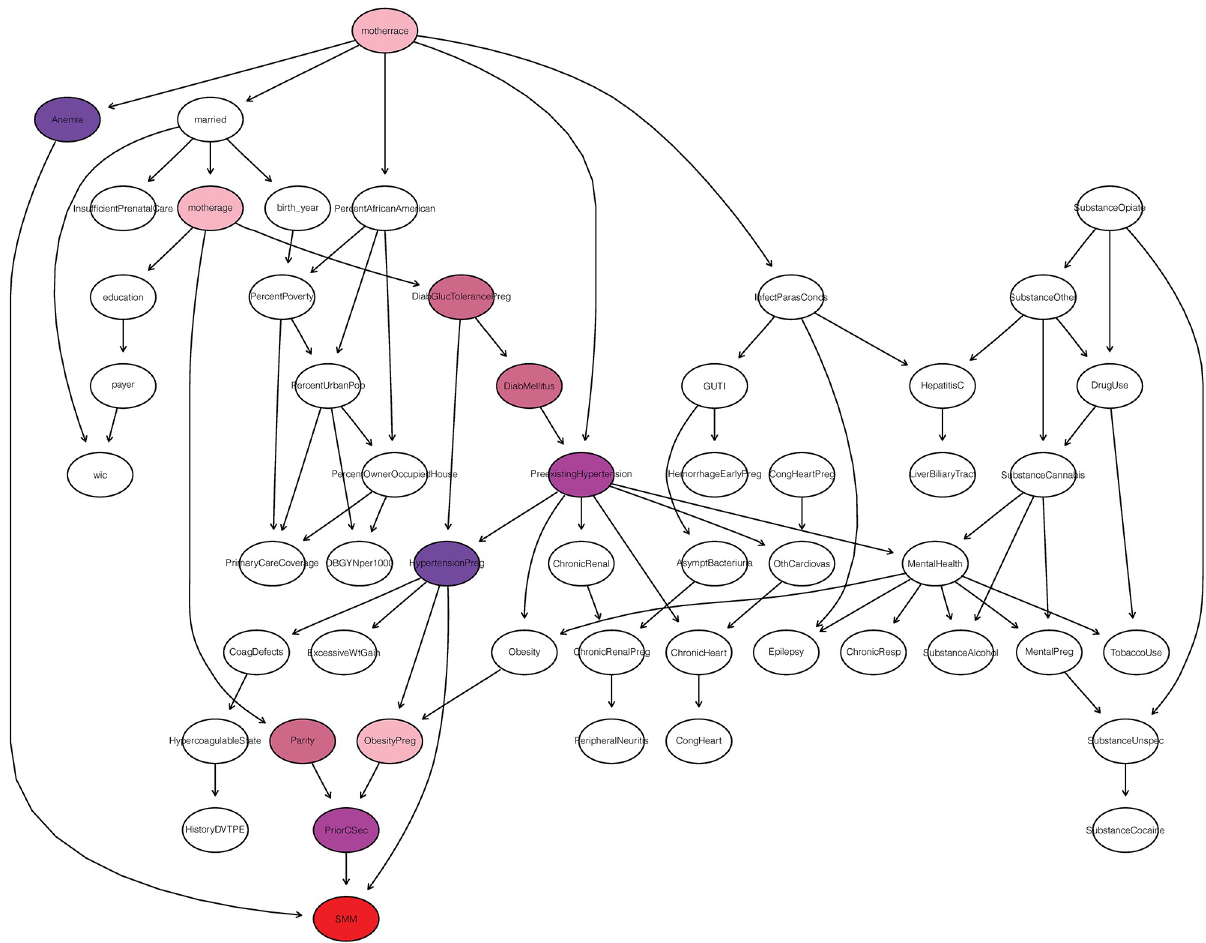
Fig 4. Heatmap of BN representing nodes influencing SMM.